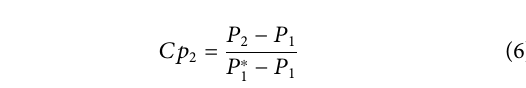
Frontiers in Energy Research |